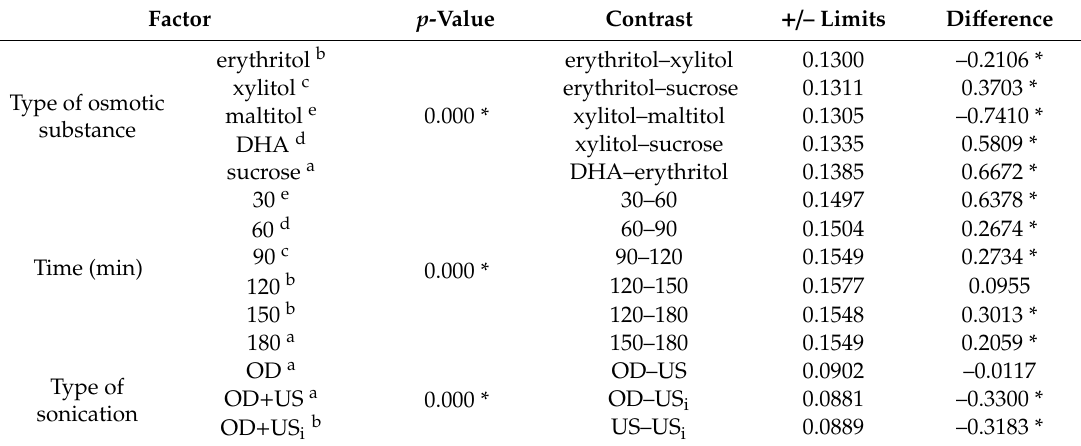
Table 2. The influence of osmotic agents and pre-treatment time on water content in